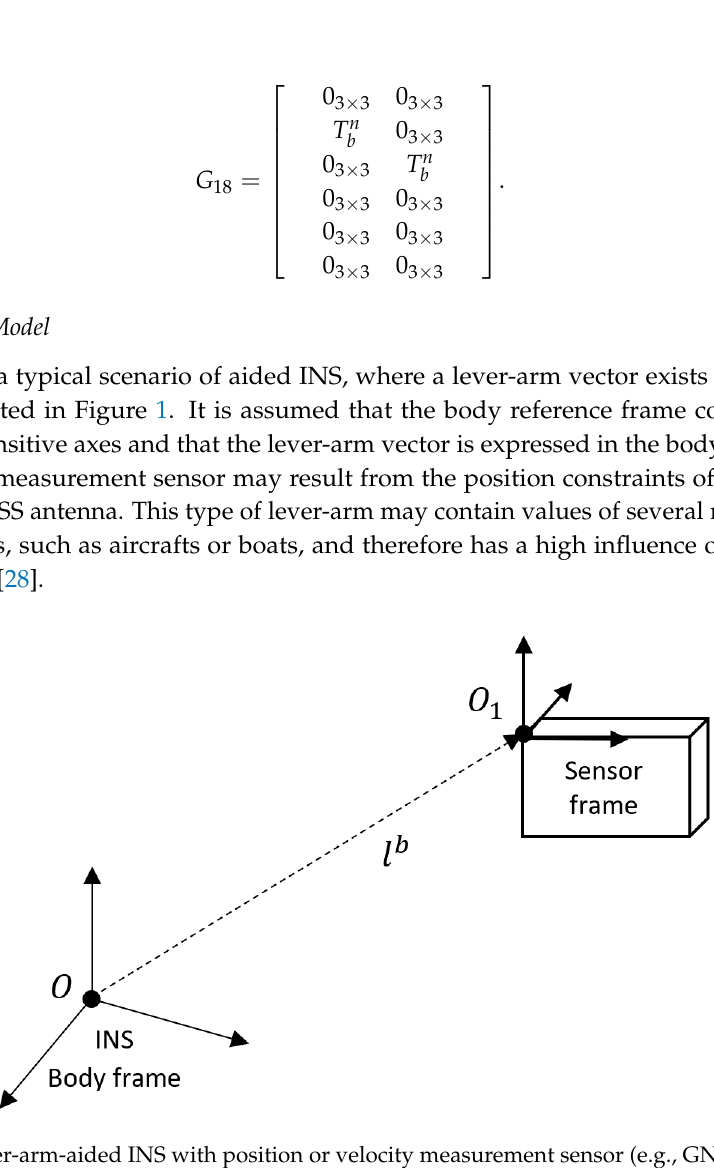
Figure 1. Lever-arm-aided INS with position or velocity measurement sensor (e.g., GNSS antenna). The measurement model can be written as